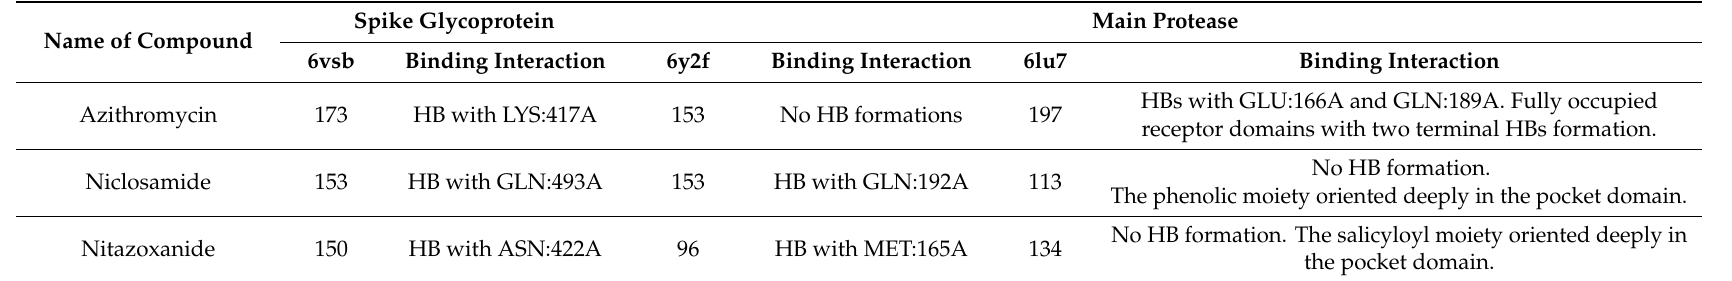
Table 3. Binding mode of most active drugs with their consensus score against spike glycoprotein and M pro